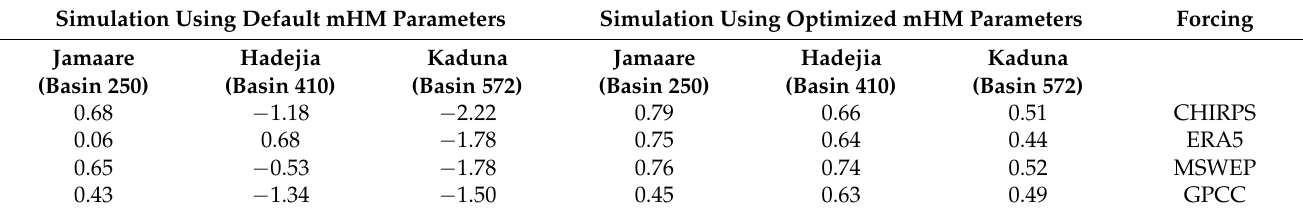
Table 3. KGE results for default and optimized mHM discharge